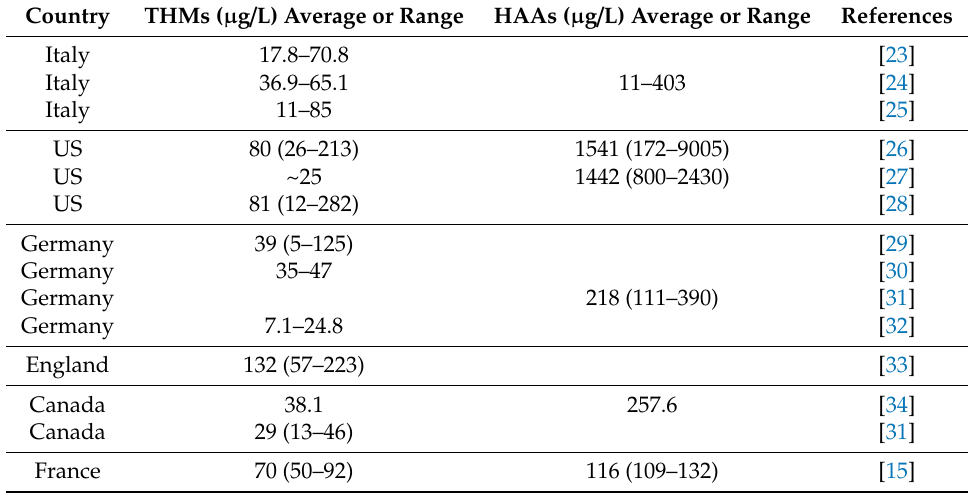
Table 3. Concentrations of THMs and HAAs in swimming pool waters in other countries (Table reported by [22] and supplemented by us).